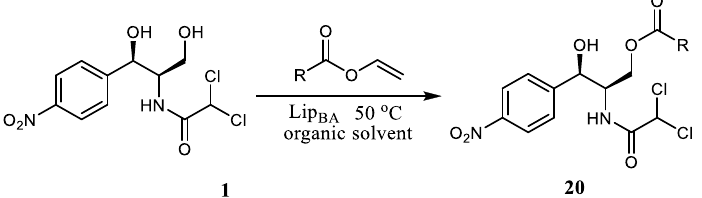
Figure 3. O -Acyl CAM derivatives identified from L. enzymogenes .